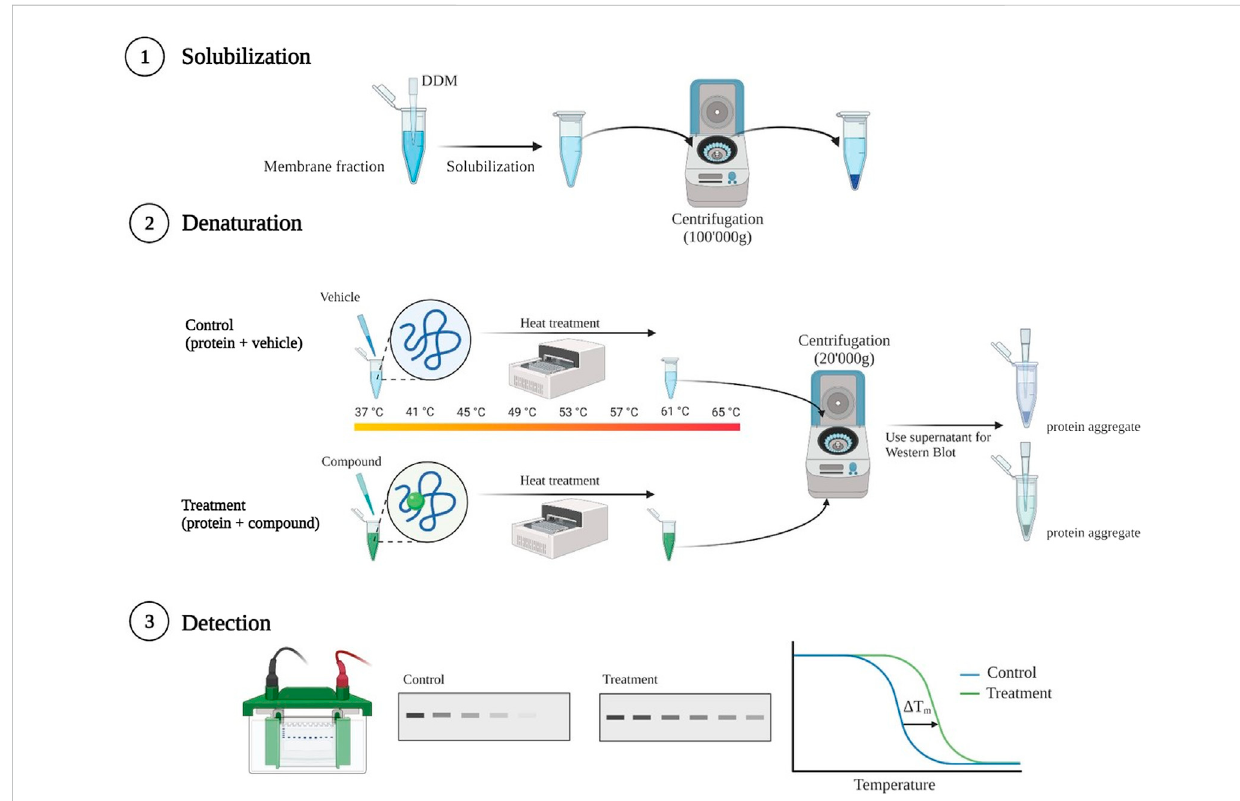
FIGURE 1 Schematicillustrationofthermalshiftassayprocedure.MembranesharboringhumanOCT2weresolubilizedusing1%Dodecyl- β -D-maltoside(DDM).Non- solubilized membranes were removed by ultracentrifugation. Thereafter, supernatant was incubated for 1 h at 4 ° C with either with the ligand at a fi nal concentration of 1 mM, or with an equal volume of vehicle. After incubation equal volumes of samples were transferred into standard pcr tubes and heated